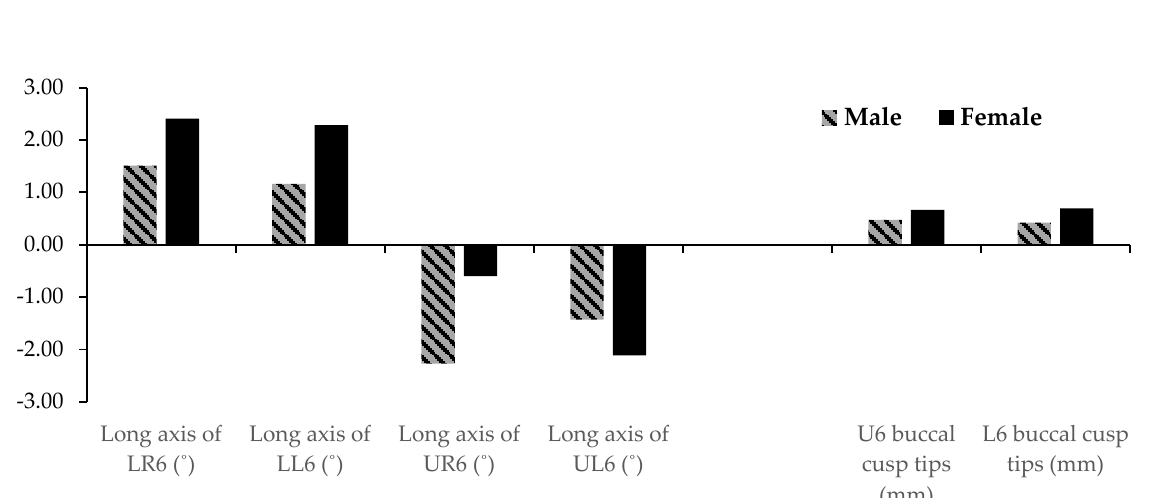
Figure 7. Dental transverse changes per year at the first molar level of the maxilla and mandible for Males (stripes) and females (solid).